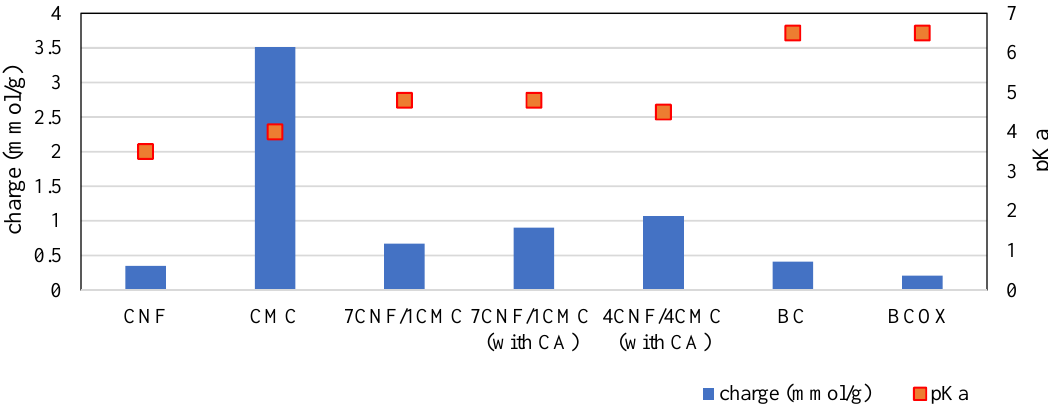
Figure 3. Potentiometric titration data of components (CMC, CNF) and cellulose membranes .